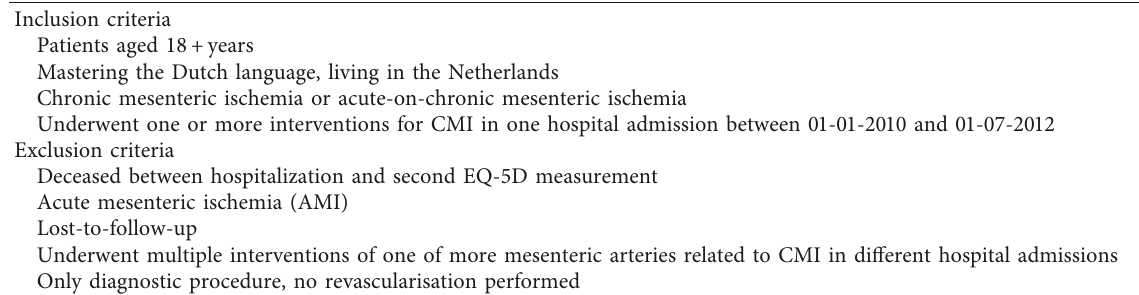
Table 1: Inclusion and exclusion criteria.